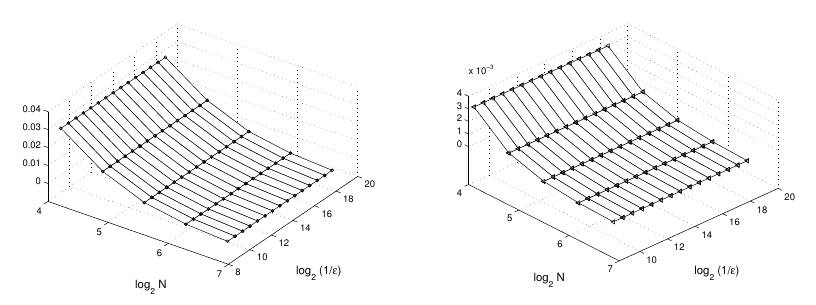
Figure 5. Surface plot of the maximum pointwise errors as a function of N and ε for the solution components Y 1 and Y 2 using HDS - I for the Example 2.